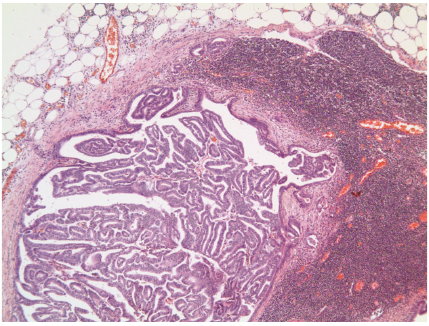
Figure 4: Metastatic endometrioid adenocarcinoma in a lymph